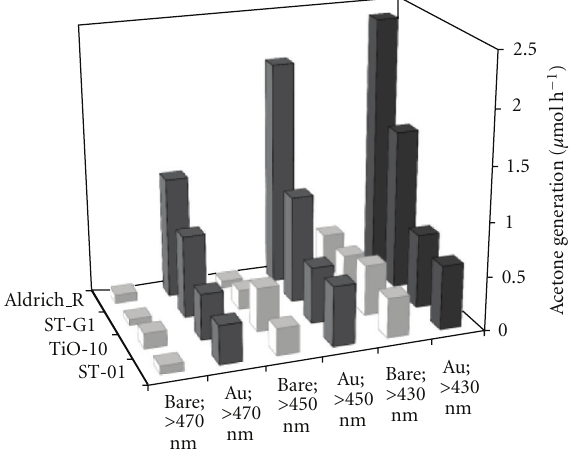
Figure 2: Comparison of rate of photocatalytic acetone evolution from suspensions containing 2-propanol and bare or gold modified titania photocatalysts (ST-01, TIO-10, ST-G1, and Aldrich R) under vis irradiation with xenon lamp and cut-o ff filters: Y48 ( λ > 470nm), Y46 ( λ > 450nm), Y44 ( λ >